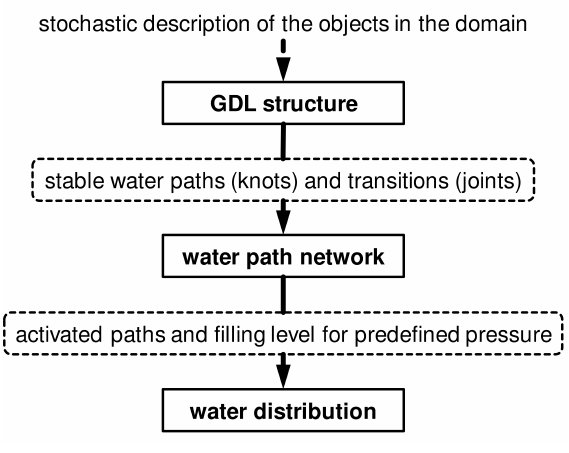
Figure 2. Schematic of the modeling